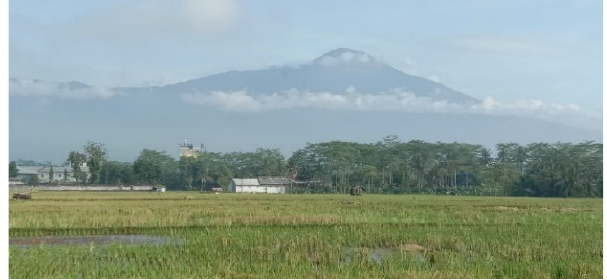
Fig. 1. The view of Slamet Volcano seen from Banyumas Regency, Central Java, Indonesia